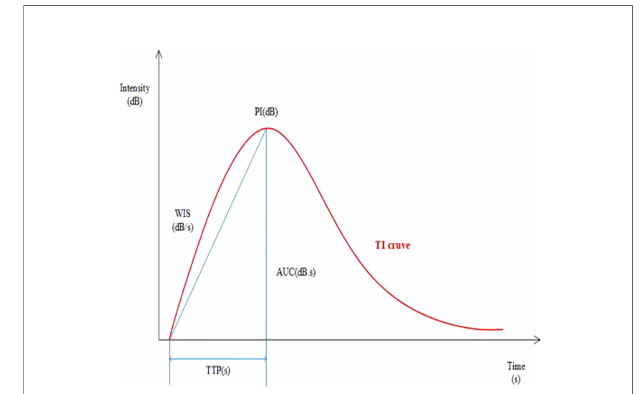
FIGURE 2 | Representation of the time-intensity curve including parameters: TI (time intensity curves), PI (peakintensity), WIS (wash in slope), AUC (area under curve), TTP (time